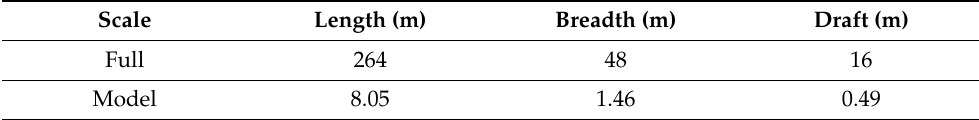
Table 2. Main dimension of target ship for scale ratio 32.8.